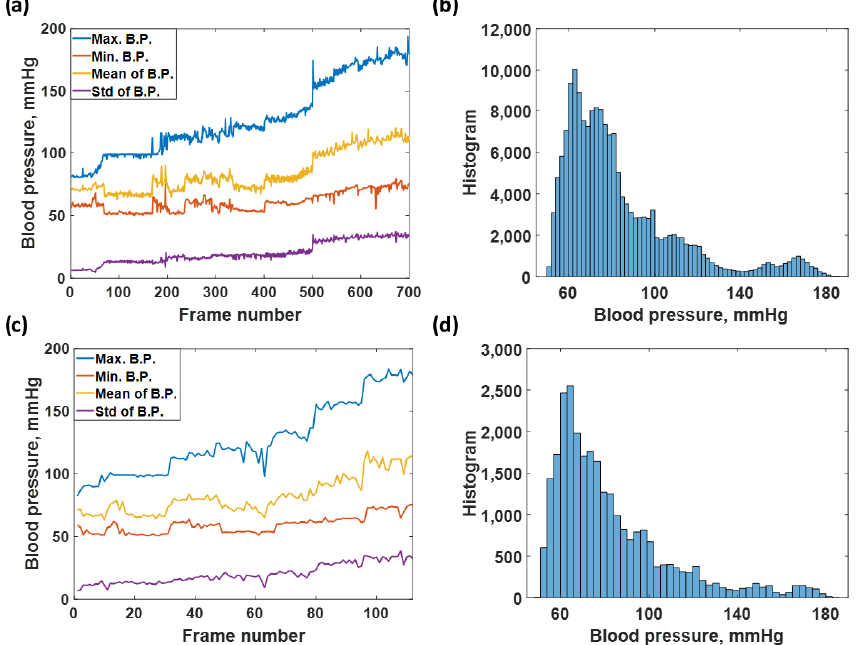
Figure 2. Shows ( a ) average maximum, average minimum, average mean, and standard deviation of each frame number for the training dataset; ( b ) histogram of blood pressure distribution covering in the training dataset; ( c ) average maximum, average minimum, average mean, and standard deviation of each frame number for the test dataset; and ( d ) histogram of blood pressure covering in the test dataset.